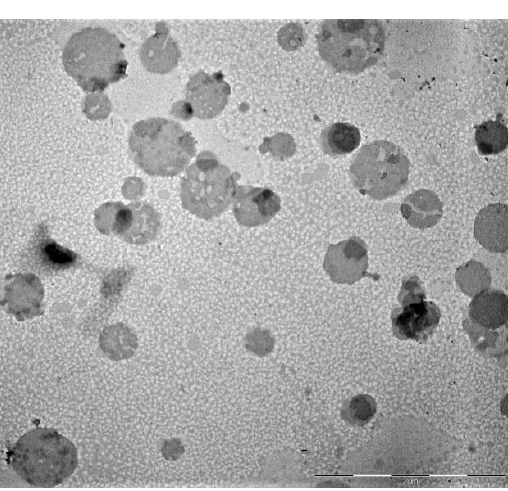
Figure 1. Transmission Electron Microscope (TEM) images of Silymarin (SLM)-NLCs. Table 2. Physical and chemical properties of empty NLCs, SLM-NLCs and Fluorescein